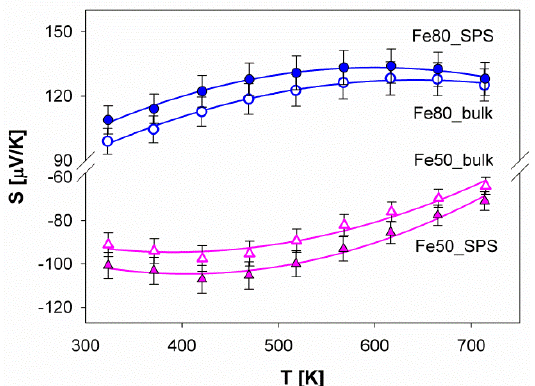
Figure 8. The trend of the Seebeck coefficient as a function of temperature for samples Fe80 and Fe50. The curves fitting the experimental points are second order polynomial functions.